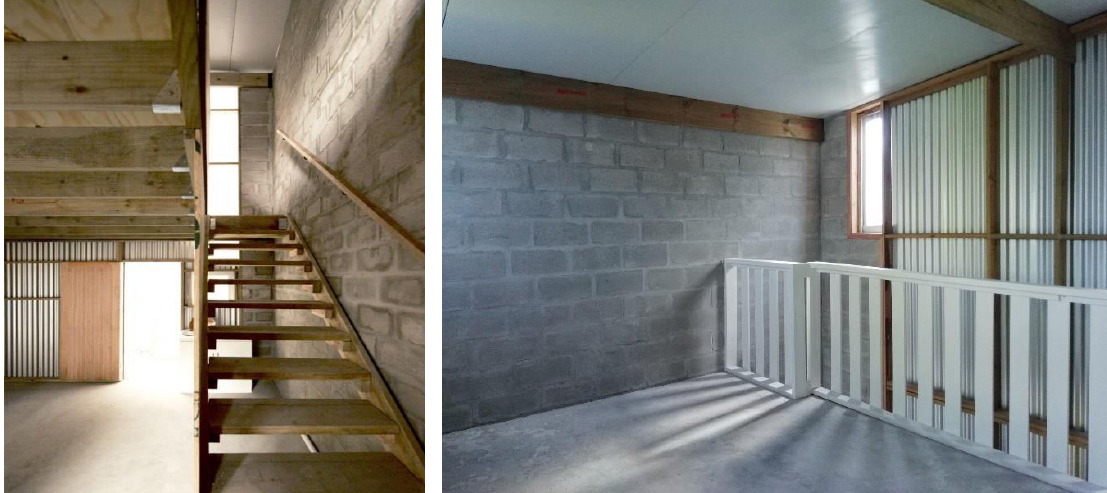
Figure 8: Ground floor interior of the Empower Shack. Dezeen.com, 2017, Figure 9: First floor interior of Empower Shack. Architizer.com,